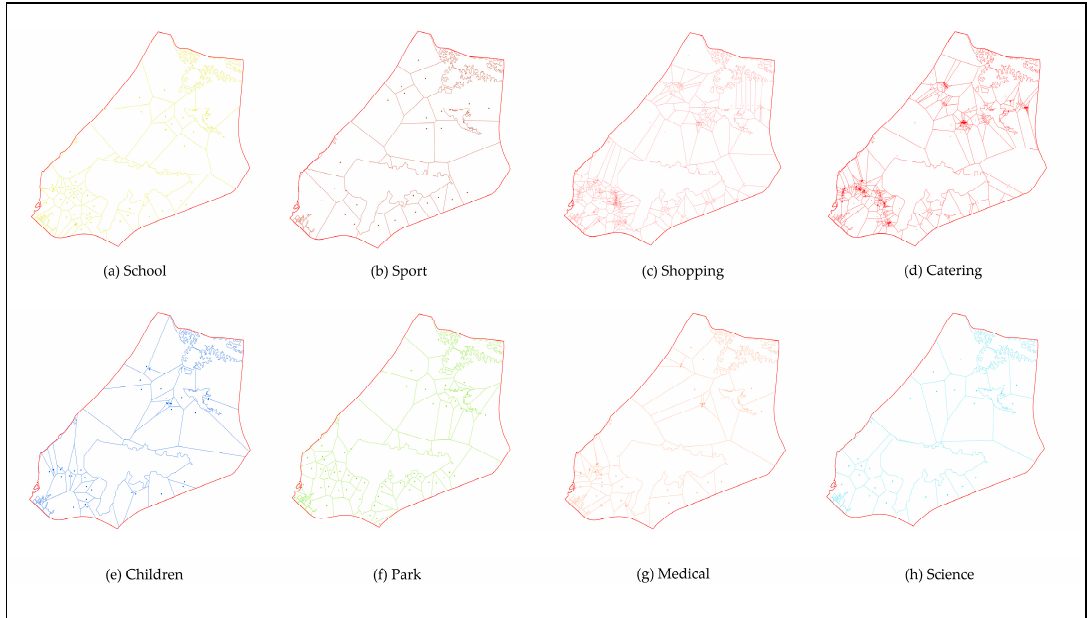
Figure 5. The service area of each public service facility.